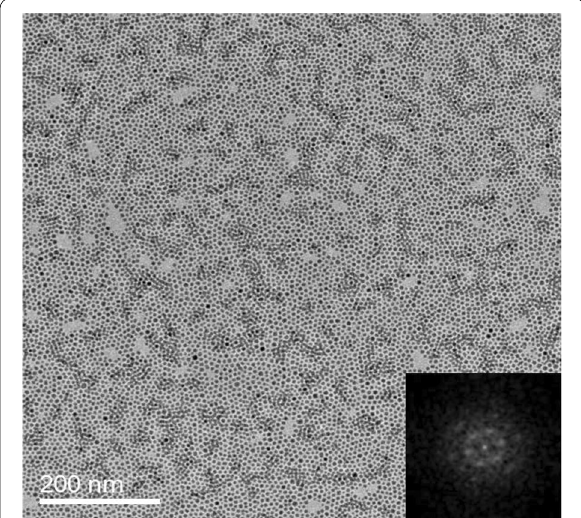
Fig. 7 TEM image of Fe nanoparticle film with nanoparticle coverage approaching 100%. The deposition is performed at an equivalent deposition rate of 0.1 Å s − 1 with a 45° glance incidence. The boundaries between the ordered monolayer domains are hardly identified. The inset shows the FFT of the nanoparticle assembling